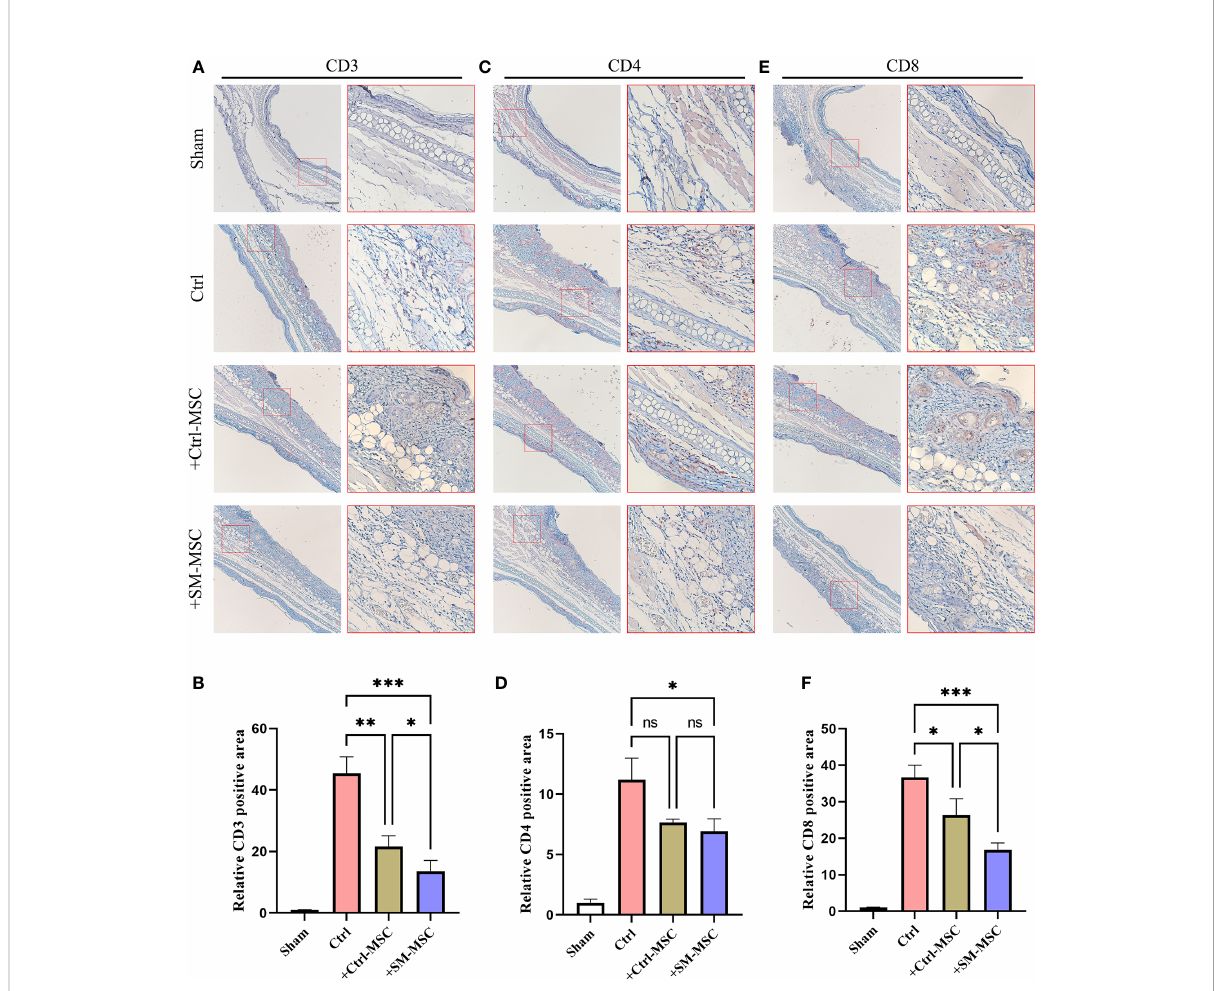
FIGURE 4 MSCs decrease T cells in ears of mouse contact hypersensitivity model. CD3 (A, B) , CD4 (C, D) and CD8 (E, F) positive areas of ears were calculated under fl uorescence microscope, n=4 per group. The relative fl uorescence positive area in the Sham group were normalized to 1.0. Scale bar = 200 m m. Data are shown as mean ± SD, *P < 0.05, **P < 0.01, ***P < 0.001 and ns means not signi fi